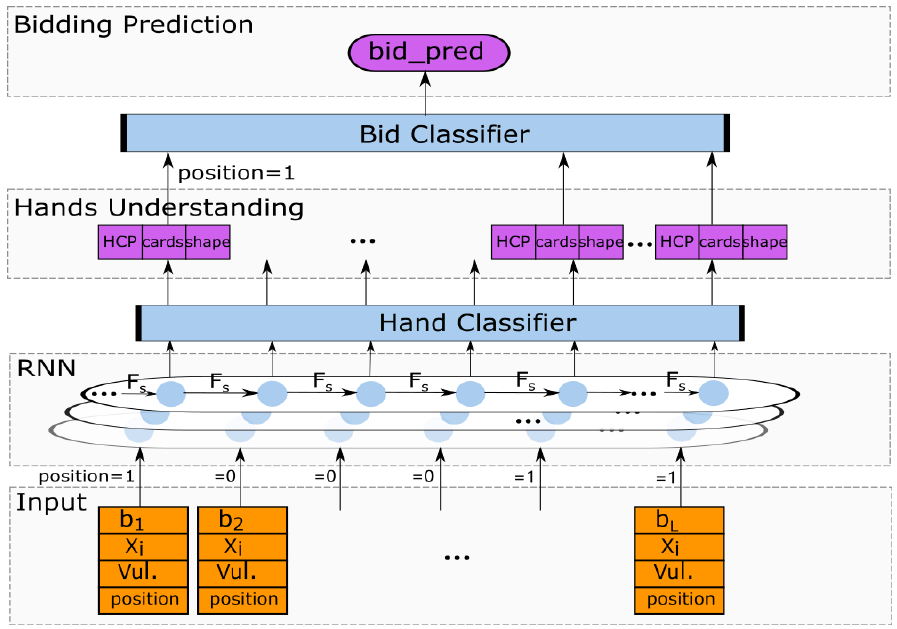
Figure 2. The structure for